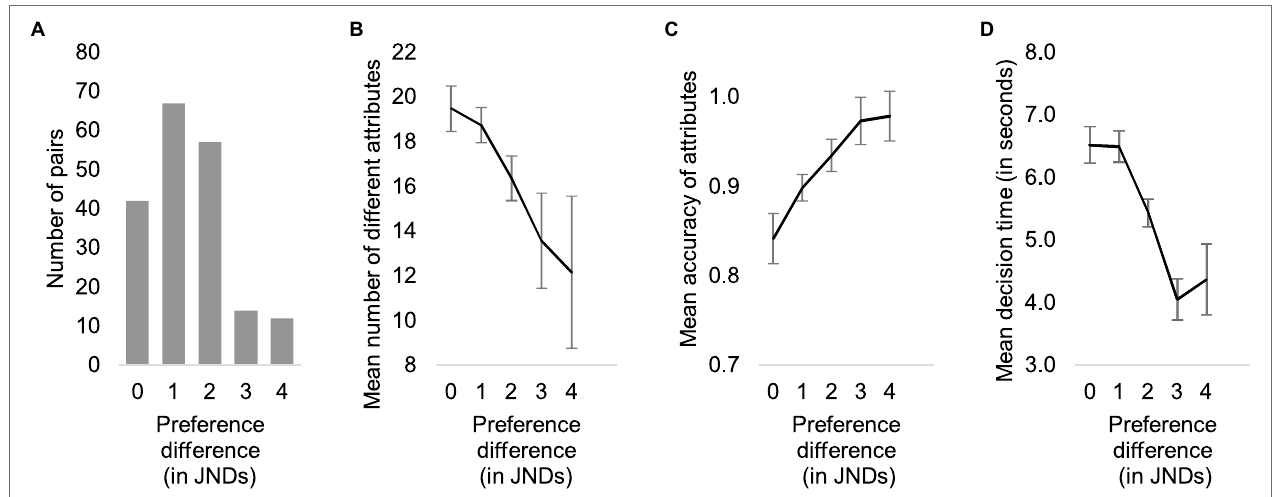
FIGURE 2 | Distribution of quality differences (A) and the qualitative shift between one and three just noticeable differences (JNDs) illustrated by three measures: mean number of different attributes (B) , mean accuracy of attributes (C) , and mean decision time (D) .